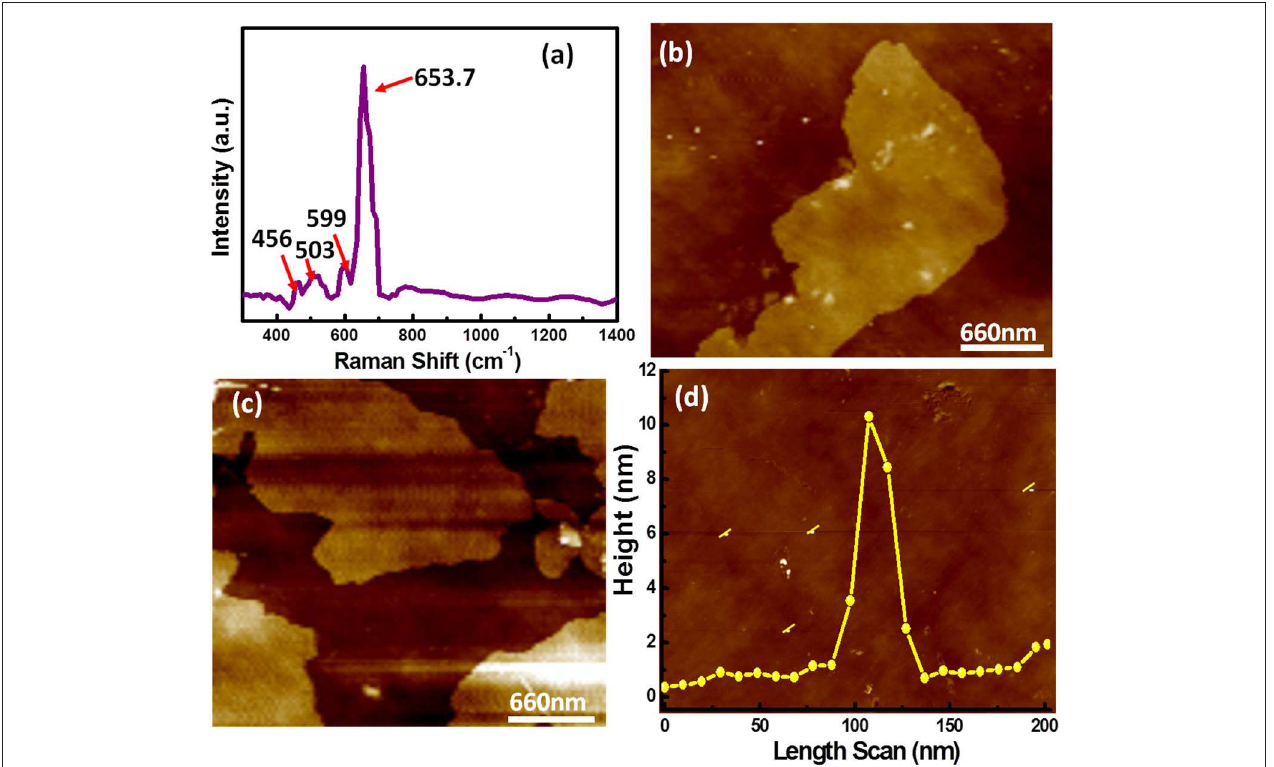
FIGURE 2 | (a) Raman spectrum of as-synthesized CuCo 2 S 4 nanosheets, (b,c) AFM images of nanosheets with (d) cross section height profile graph showing the average height of CuCo 2 S 4 nanosheets ∼ 10–12nm.